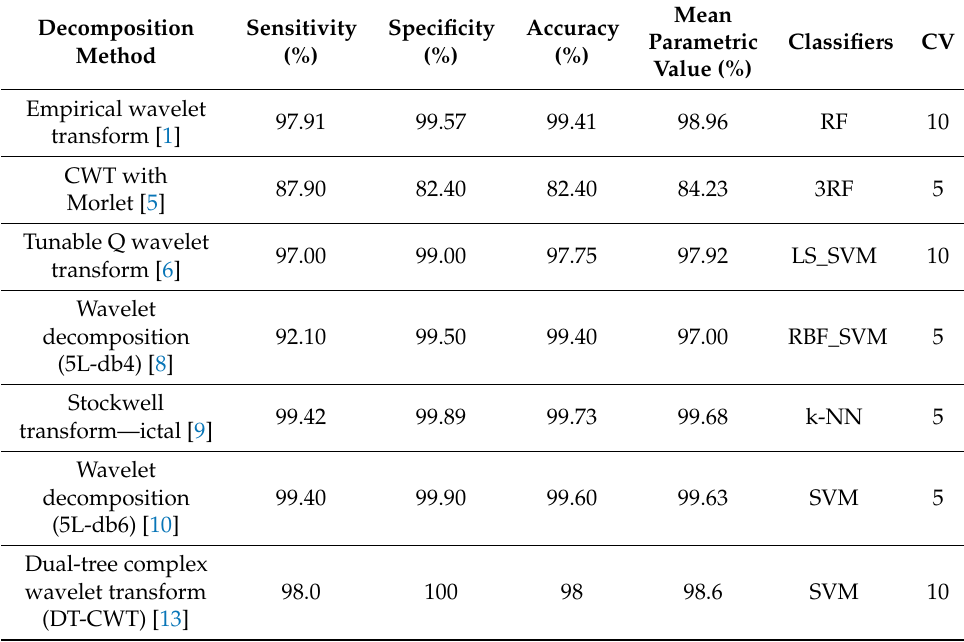
Table 2. Performance comparison of wavelet-based epileptic seizure